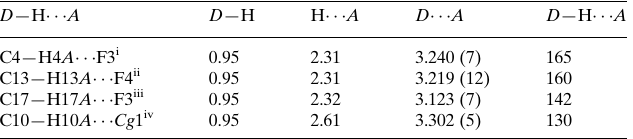
Hydrogen-bond geometry (A˚ , (cid:3)